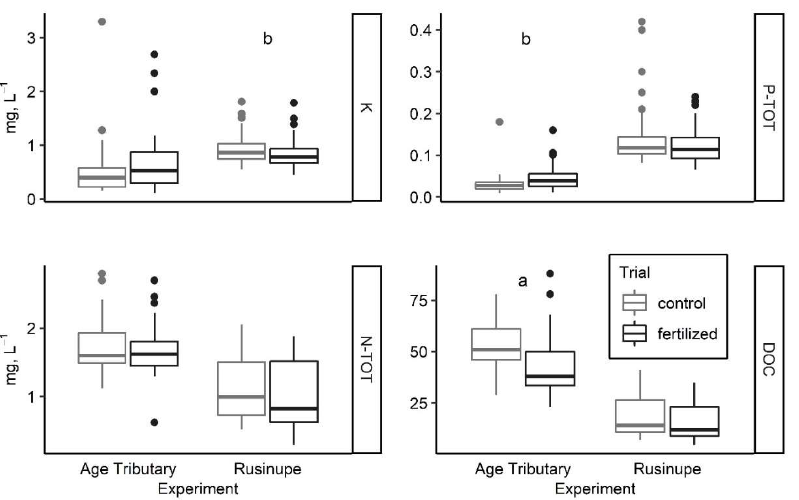
Figure 2. Average concentration of aquatic chemistry parameters (Figure indicates 25th, 50th, and 75th percentile, minimal and maximal value, and outliers) as influenced by forest fertilization in two hemiboreal streams in Latvia: ( a ) p < 0.01; ( b ) p < 0.05. We detected a statistically significant increase in P TOT concentration (from 0.03 ± 0.01 to 0.04 ± 0.00, p < 0.05) and a significant decrease of dissolved organic carbon (DOC) con- centration (from 52.96 ± 2.46 to 41.62 ± 2.19, p < 0.01) after the application of wood ash in the Age catchment area. The average pH of water samples from the Age tributary ranged from 7.29 ± 0.05 (upstream) to 7.29 ± 0.06 (downstream). The average N TOT concentration did not indicate any nutrient loading of the applied NH 4 NO 3 from the fertilized forest stand in the Rusinupe catchment area. The concentration of N TOT was slightly lower down- stream of the fertilized forest stand (1.12 ± 0.06 control and 1.00 ± 0.06 fertilized). However, a significantly lower ( p < 0.05) concentration of K (0.92 ± 0.03 control and 0.83 ± 0.03 ferti- lized) was detected in surface water downstream of the treatment site in Rusinupe.